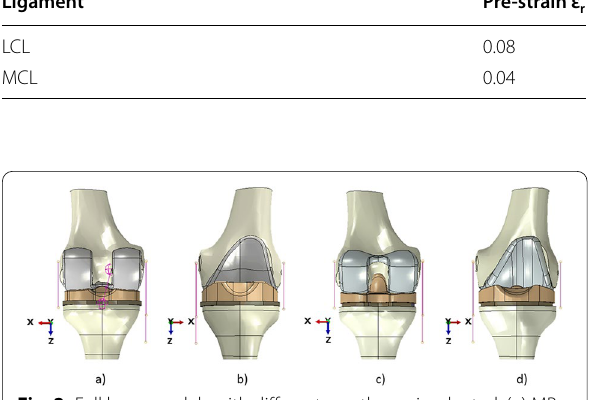
Fig. 2 Full knee models with different prostheses implanted; ( a ) MB CR prosthesis, posterior view; ( b ) MB CR prosthesis, anterior view; ( c ) FB PS prosthesis, posterior view; ( d ) FB PS, anterior